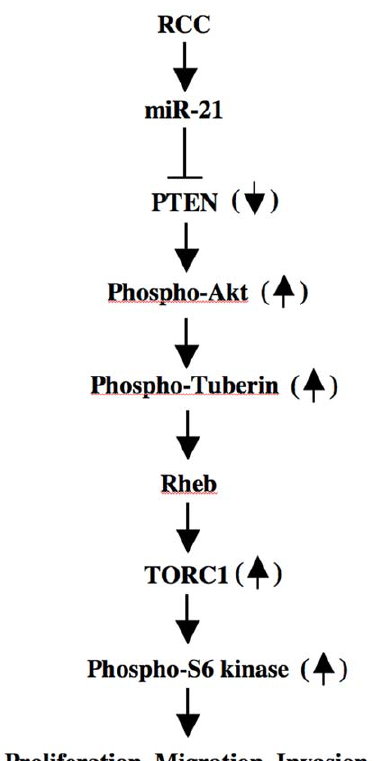
Figure 9. Schematic demonstrating our results. Enhanced miR-21 attenuates PTEN protein levels, resulting in activation of Akt, which inactivates tuberin to increase TORC1 activity leading to proliferation, migration and invasion of renal cancer cells.